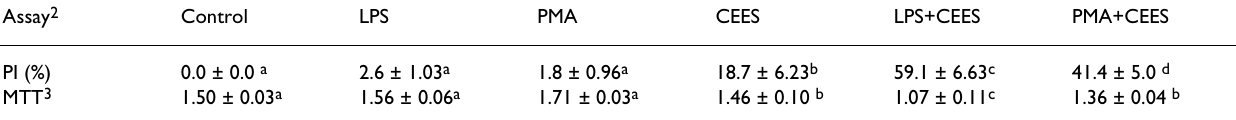
Table 3: PMA Enhances the Cytotoxicity of CEES to RAW264.7 Macrophages (24 hours) 1 Assay